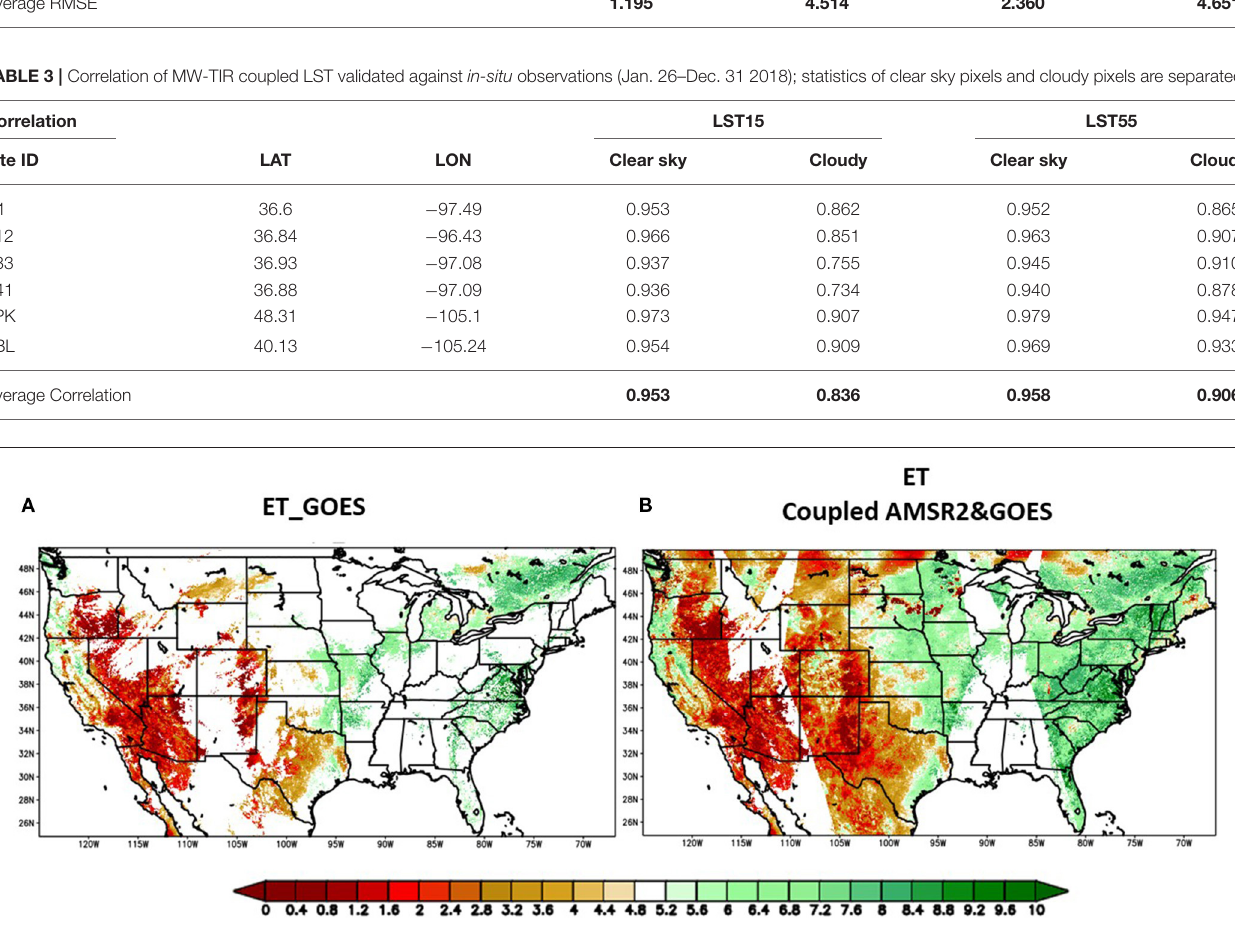
FIGURE 7 | Visual comparison of clear-sky ET derived from GOES16/17 (A) and all-weather ET derived from GOES/AMSR2/CFSR combined LST (B) on May 30, 2018; Unit: mm/day.